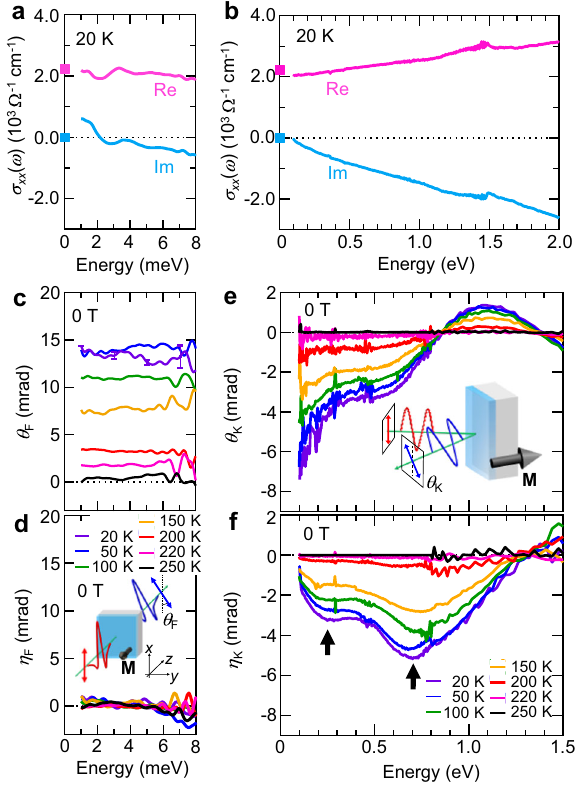
Fig. 2 Optical conductivity and magneto-optical effect. The longitudinal optical conductivity spectra σ xx ( ω ) at 20 K in the terahertz a and the mid-to-near infrared b regions. The terahertz Faraday rotation θ F c and ellipticity η F d spectra at various temperatures. The error bars in c indicate the standard deviation. The inset of d shows the schematic illustration of the Faraday rotation measurement. The infrared Kerr rotation θ K e spectra and ellipticity η K f spectra at various temperatures. The inset of e shows the schematic illustration of the Kerr rotation